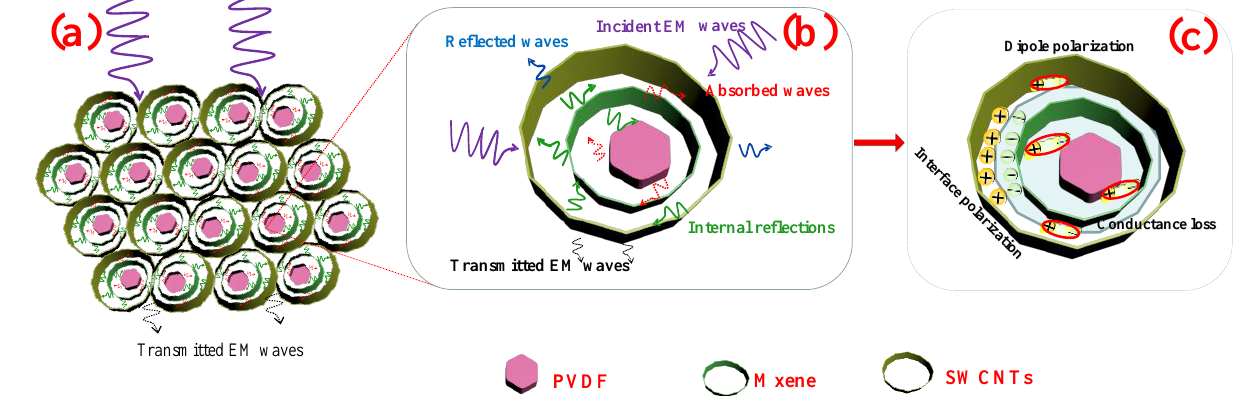
Figure 8. ( a ) EMI shielding mechanism in layered heterogeneous conductive-filler segregated struc- ture; ( b ) repeated reflection and refraction of EM waves by segregated structure; ( c ) interfacial po- larization, dipole polarization, and conduction loss of EM waves for PVDF-MXene-SWCNTs. The segregated PVDF composites are filled with layered fillers (SWCNTs and